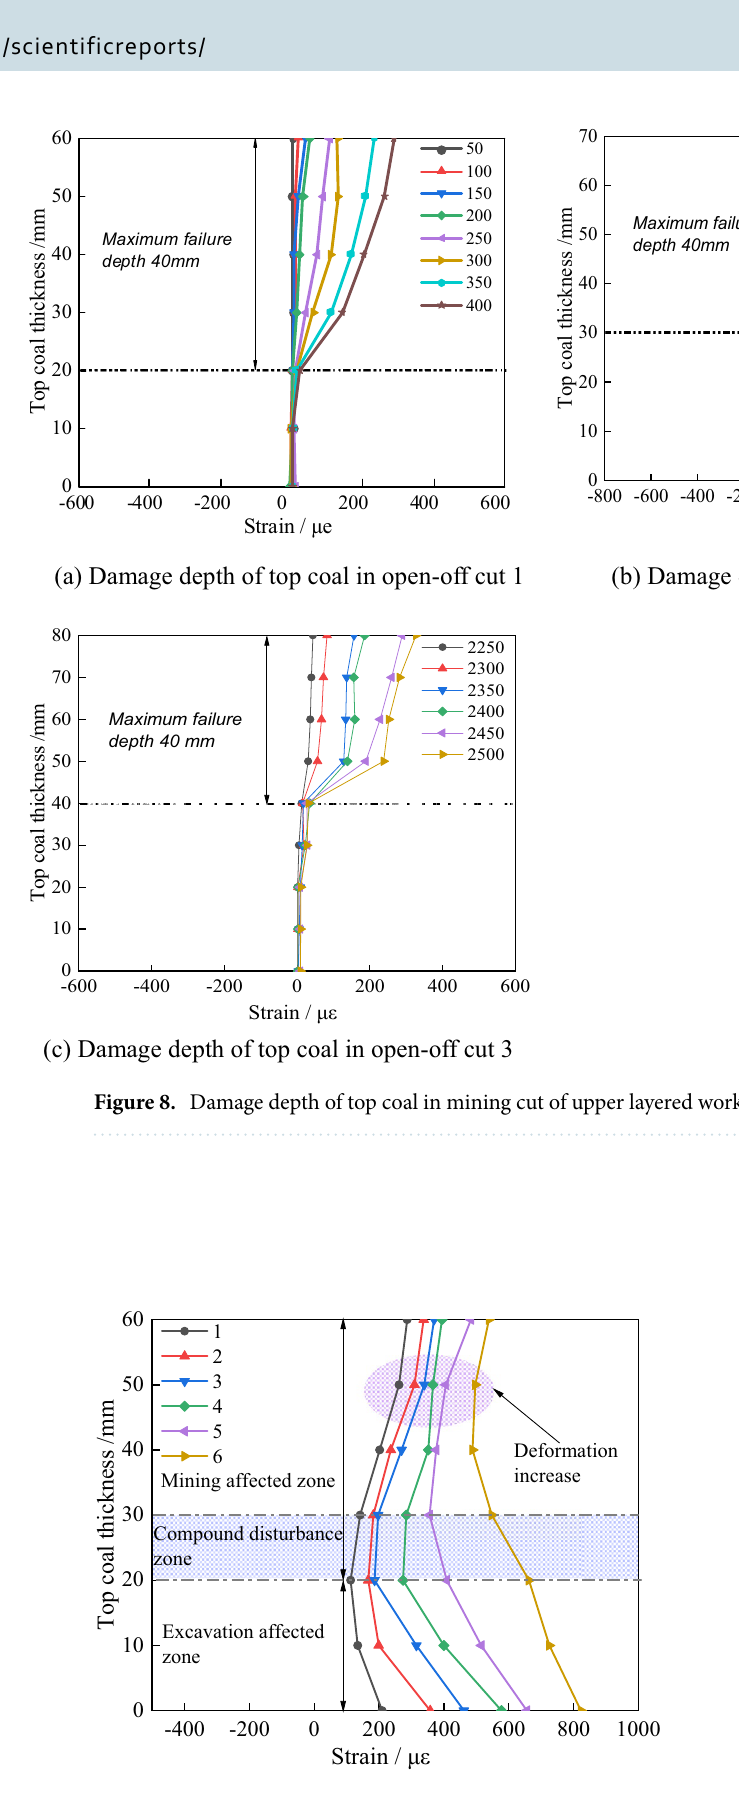
Figure 9. Deformation characteristics of top coal during excavation of the open-off cut